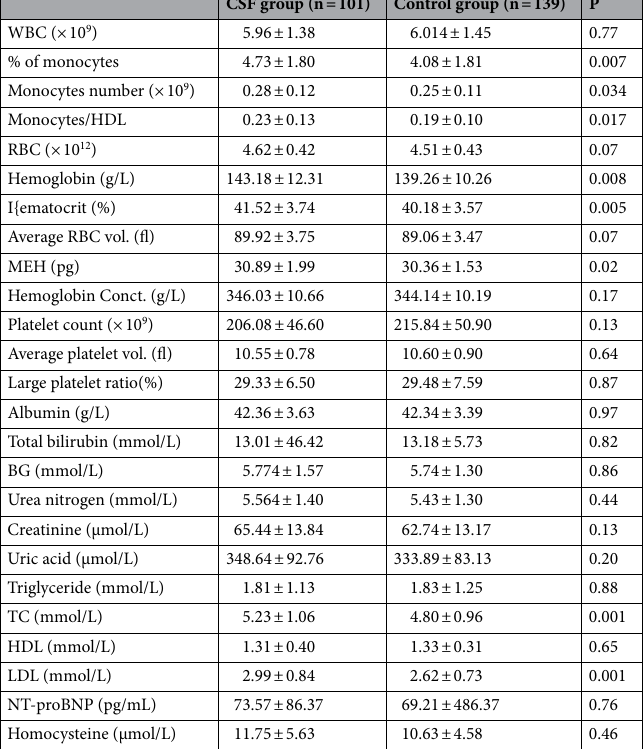
Table 3. Blood routine and biochemical test information. Values shown are means ± SD or percentages. WBC white blood cells, RBC red blood cells, FBG fasting blood glucose, MEH mean erythrocyte hemoglobin, TC total cholesterol, HDL high density lipoprotein cholesterol, LDL low density lipoprotein cholesterol, NT-proBNP N-terminal pro B-type natriuretic peptide.